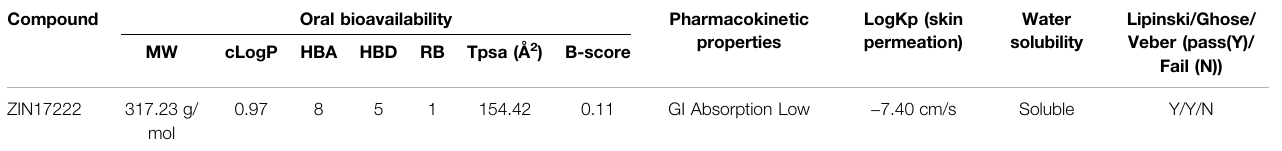
TABLE 2 | Summary of the ADME-Tox results performed using SWISS-ADME server. Compound